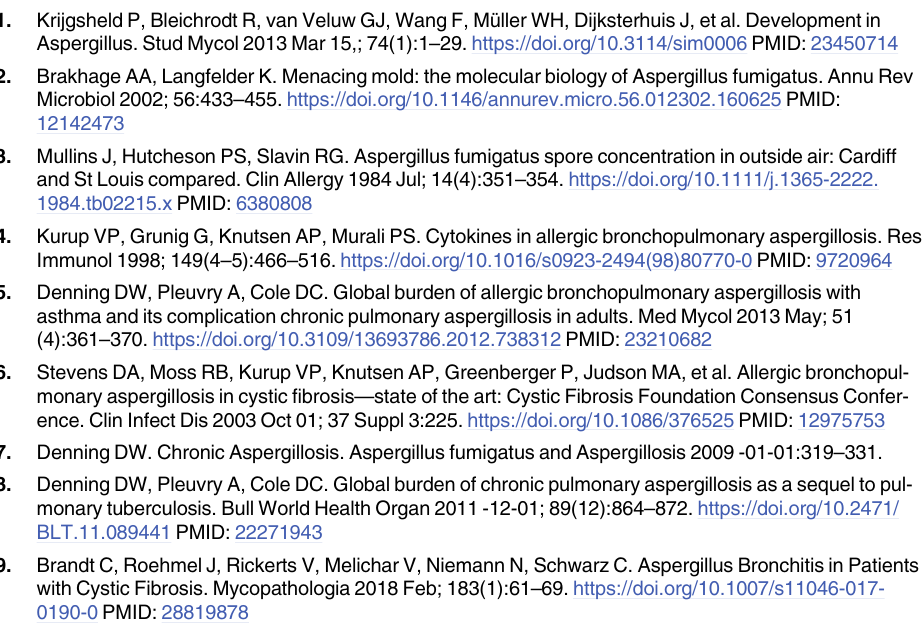
S6 Table. Base pair (BP) change, location and amino acid (AA) substitution in the FtmD (Afu8g00200) gene. The SNPs described by [58] is highlighted in